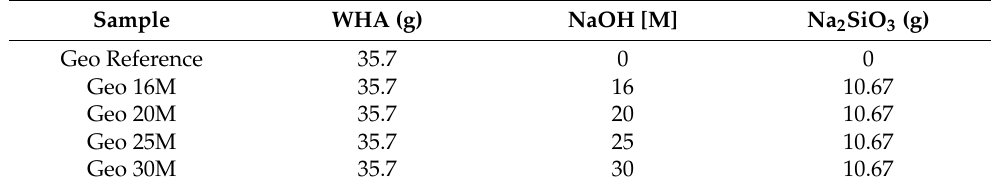
Table 1. Geopolymer formulations consisting of wheat husk ash (WHA), sodium hydroxide (NaOH), and sodium silicate (Na 2 SiO 3 ).